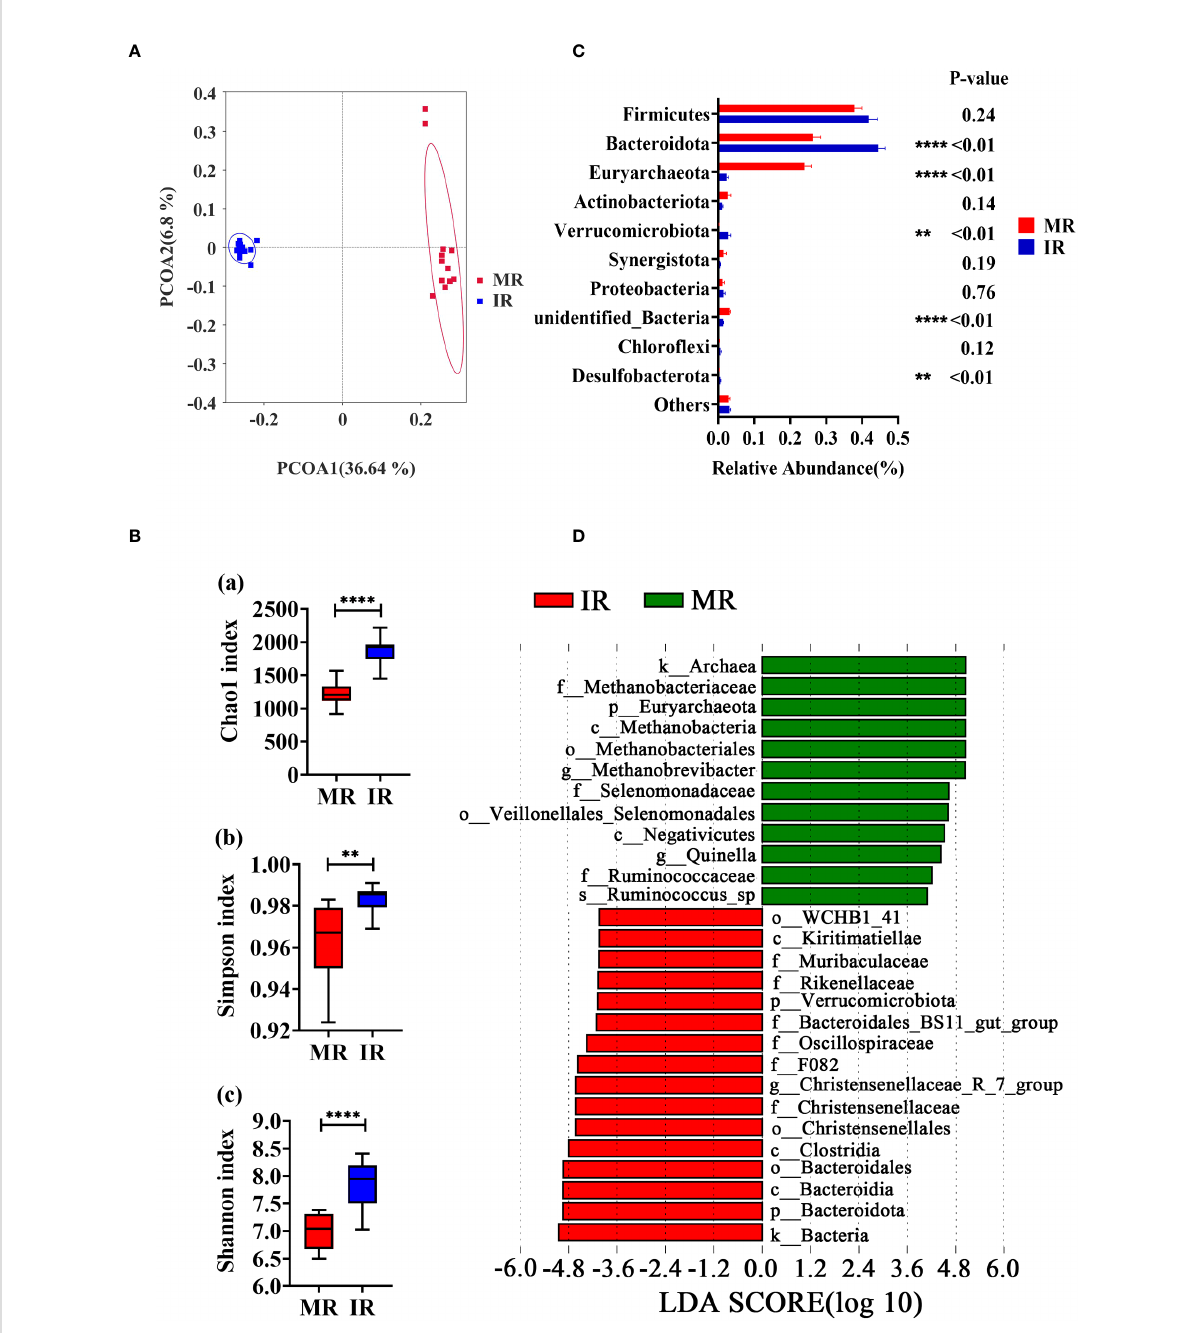
FIGURE 2 Comparison in rumen microbiome between adults and young goats. (A) Principal coordinate analysis (PCoA) of microbial based on unweighted UniFrac distances. (B) Alpha diversity (Chao1 index; Simpson index; Shannon index). (C) Relative abundance of top10 phyla. (D) Bar chart shows LDA score of young and adult goats. LDA score > 4. MR: rumen of adult goats. IR: rumen of young goats. The data were analyzed with unpaired t tests, and the data were expressed as mean ± SEM. ** P < 0.01, **** P <